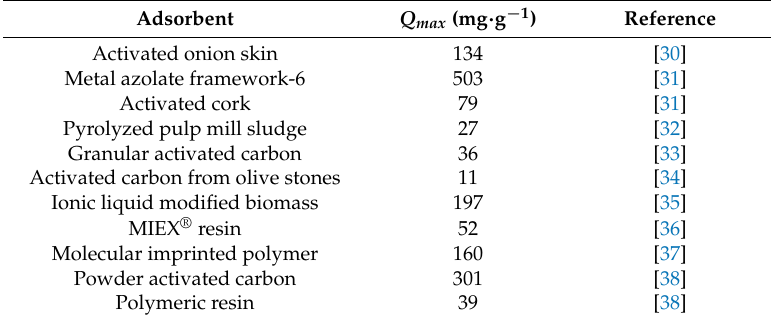
Table 2. Maximum adsorption capacities Q max (mg · g − 1 ) of different types of adsorbents used for